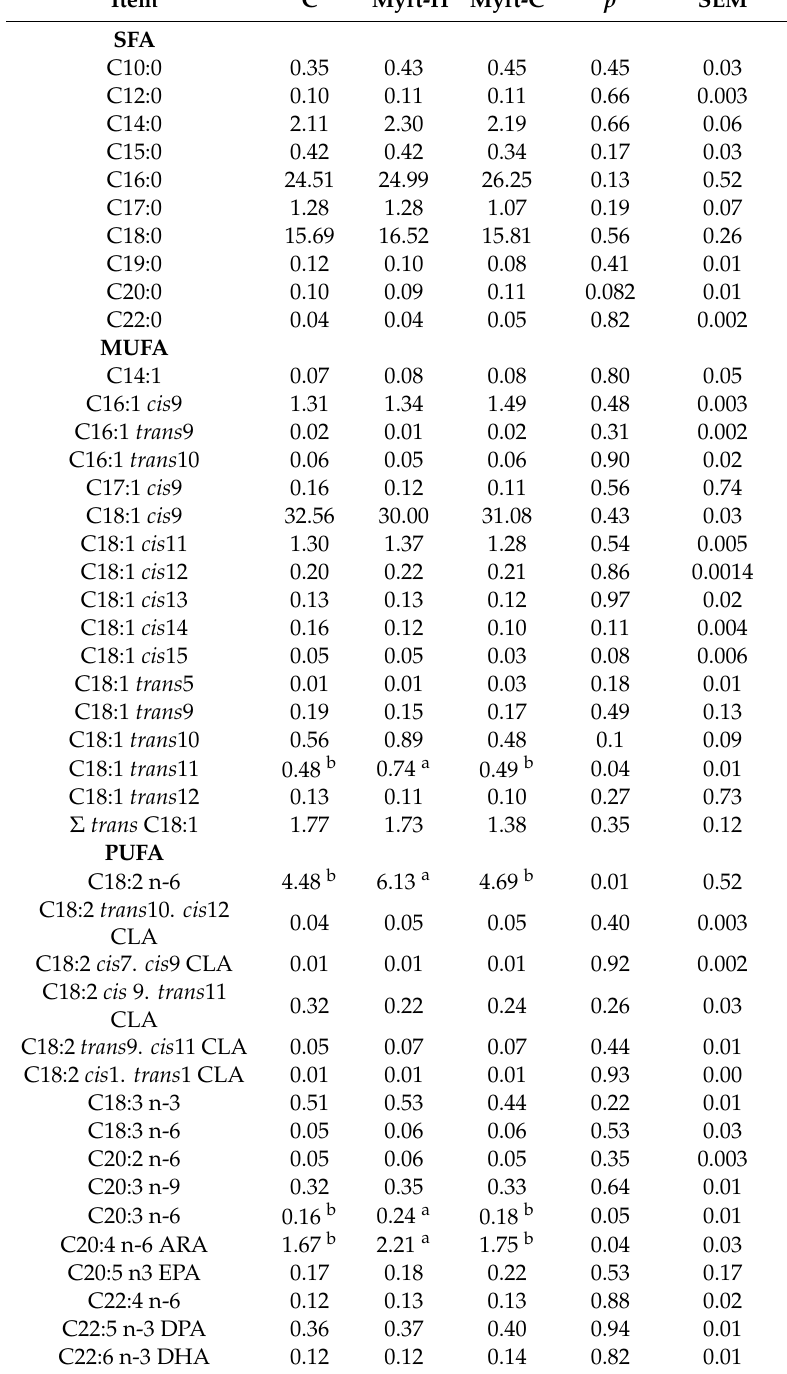
Table 3. Fatty acid profile (% of total fatty acid methyl esters (FAME)) of meat from ewes fed myrtle